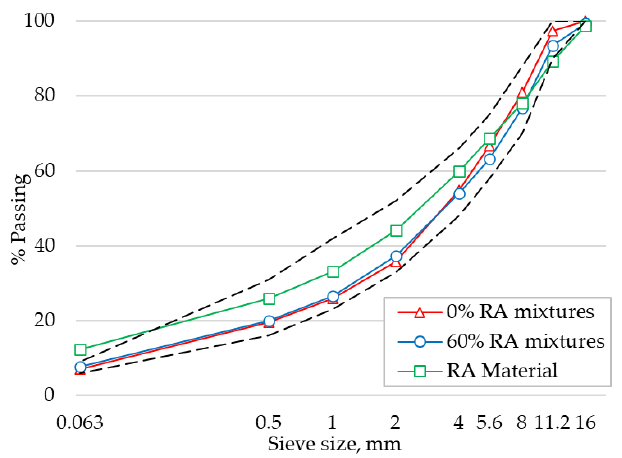
Figure 2. Mixture and extracted RA aggregates gradation.